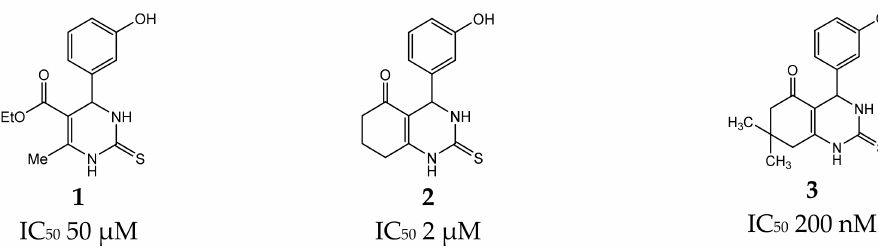
Figure 1. Replacement of ester group of monastrol ( 1 ) with acyl group increases anticancer activity.